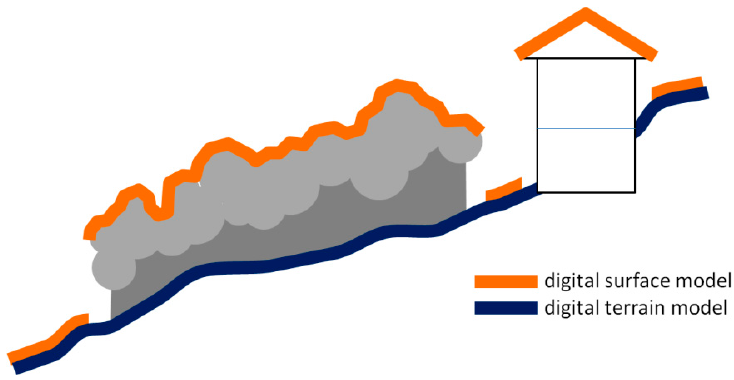
Figure 2. DTM vs DSM in the presence of trees and buildings.